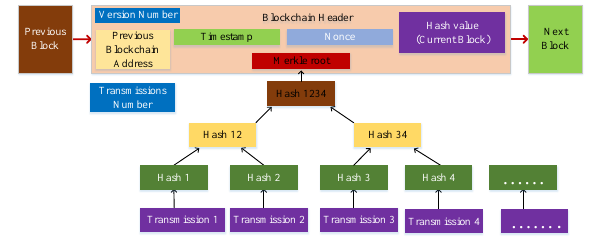
Figure 2. General structure of blockchain